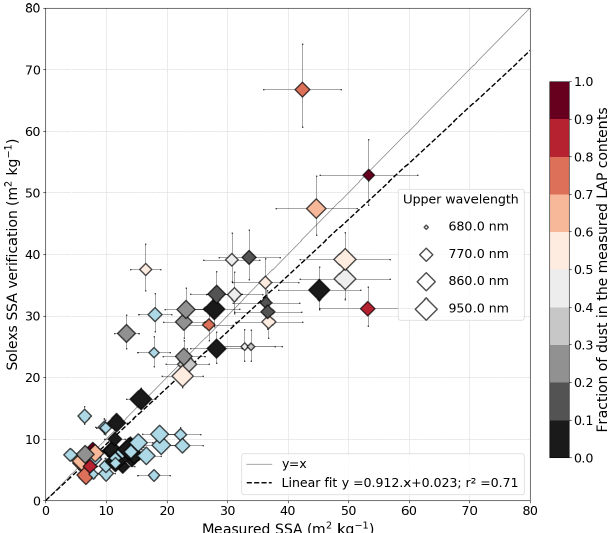
Figure 10. Comparison between measured and estimated SSA for all the ZOIs with concomitant SSA measurement. The colour of the symbols corresponds to the proportion of LAP absorption com- ing from dust, and sizes are related to the upper wavelength of the AFEC estimation. Symbols are blue when chemical measurements are not available.